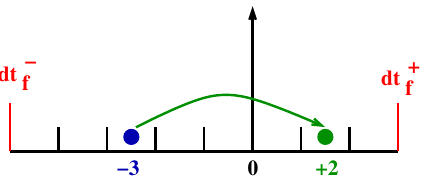
Figure 7. Time shift operator. The new time shift for the flight f is randomly selected in a time domain defined by two bounds. A negative bound: dt − the former time shift was − 3 (blue dot) and the new generated time shift is +2 (green dot).